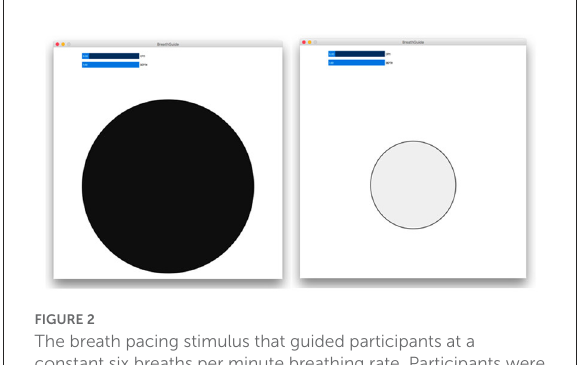
FIGURE2 The breath pacing stimulus that guided participants at a constant six breaths per minute breathing rate. Participants were instructed to inhale as the circle grew and became darker (left) , and exhale as it got smaller and lighter in color (right)